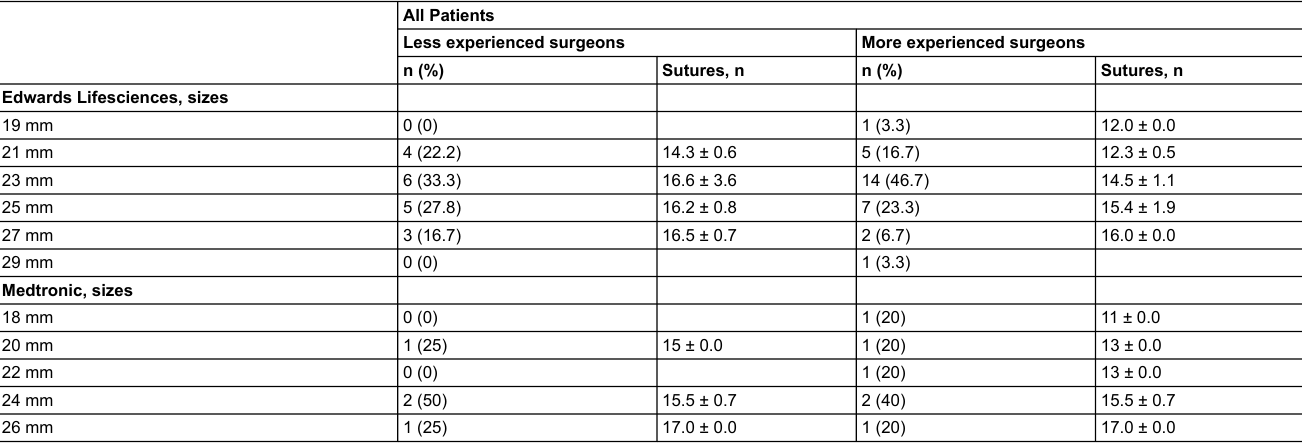
Table 3: Type of aortic valve prosthesis and number of sutures required.